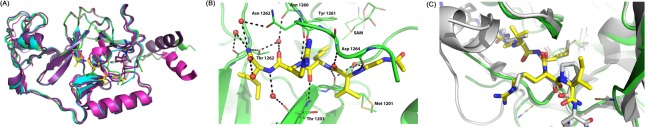
WHSC1L1 1054–1285 has a similar overall structure in relation to other NSD family proteins and can form a ternary complex with SAM and PTD2.(A) Superposition of NSD family proteins (green/yellow = WHSC1L1-PTD2 (PDB code = 6CEN); cyan = WHSC1L1 (PDB code = 5UPD); magenta = WHSC1 (PDB code = 5LSU); purple = NSD1 (PDB code = 3OOI). All protein chains are shown as ribbons; SAM and PTD2 are depicted in stick representation. (B) Structure of WHSC1L1-PTD2-SAM ternary complex. Hydrogen bonds are indicated with dashed lines. (C) Superposition of WHSC1L1-PTD2 and SETD2-H3.3 K36M (grey; PDB code = 5JJY).